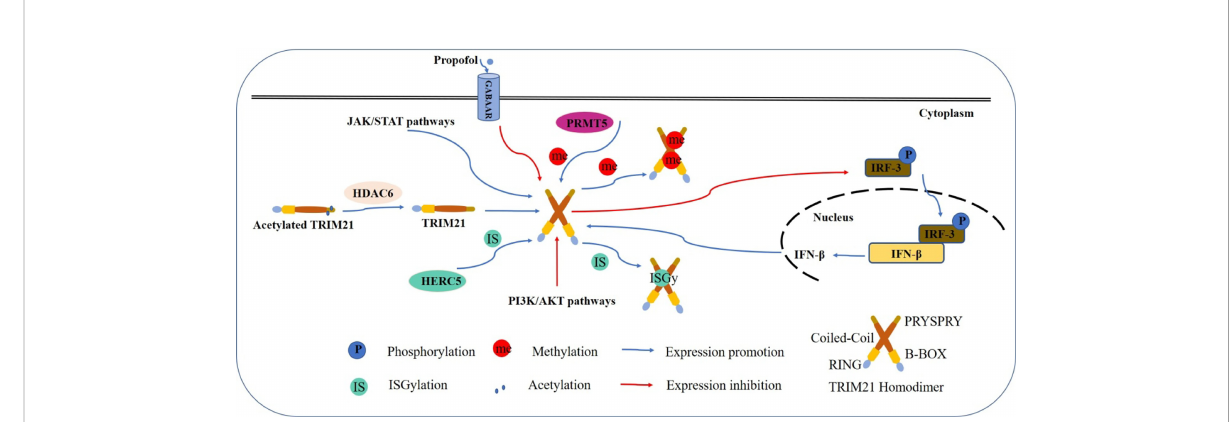
FIGURE 2 Model shows the regulatory mechanism of TRIM21. Multiple mechanisms are involved in the regulation of TRIM21 expression. TRIM21 expression is augmented by stimulation with IFNs induced by IRFs. There is a feedback mechanism to inhibit IFN production by promoting the ubiquitination and subsequent proteasomal degradation of IRFs. PRMT5-induced arginine methylation inhibits TRIM21 function, while HDAC6 deacetylates TRIM21 to promote its homodimerization and stabilizes its ubiquitination function. ISGylated by HERC5 also leads to enhanced TRIM21 E3 ligase activity. JAK/STAT signaling pathway induces the expression of TRIM21, while PI3K/AKT pathway activity is negatively correlated with TRIM21 expression. Propofol downregulates TRIM21 expression without detailed